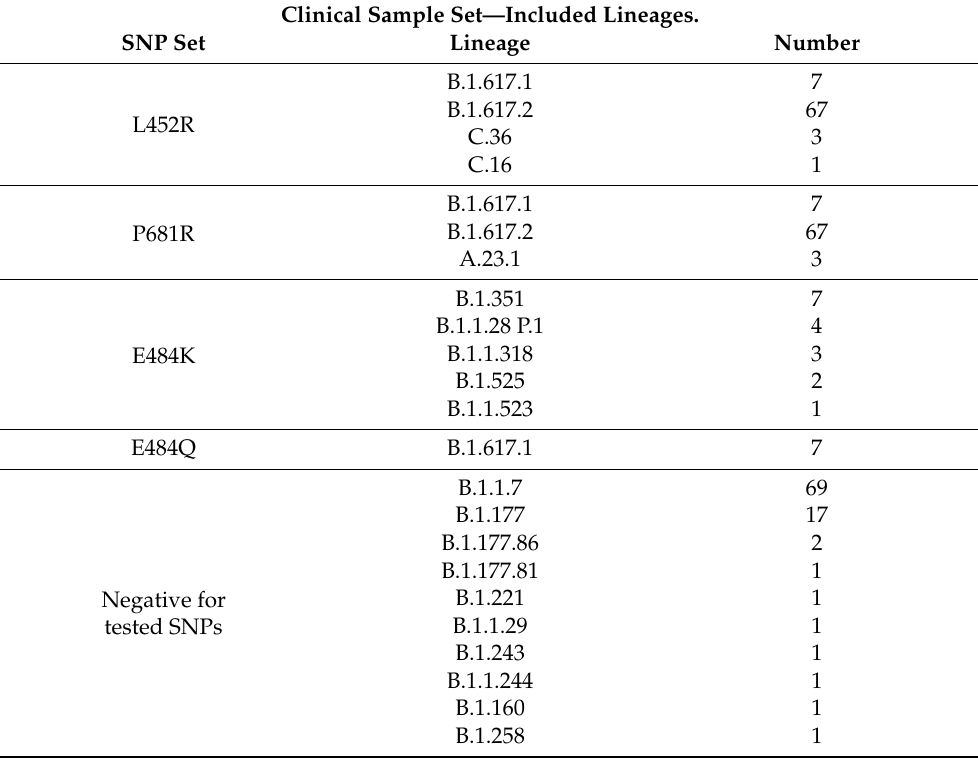
Table 4). All SNPs were detected correctly by the assay (179/179 SNPs) (Table 5). Table 4. SARS-CoV-2 lineages included in the clinical sample set. Lineages were assigned based on whole genome sequencing, as part of the Hamburg Genome Surveillance Project (https://www.hpi- hamburg.de/en/, accessed on 28 June 2021). The total number of SARS-CoV-2 RNA positive samples (any lineage) was 194. Clinical Sample Set—Included Lineages.